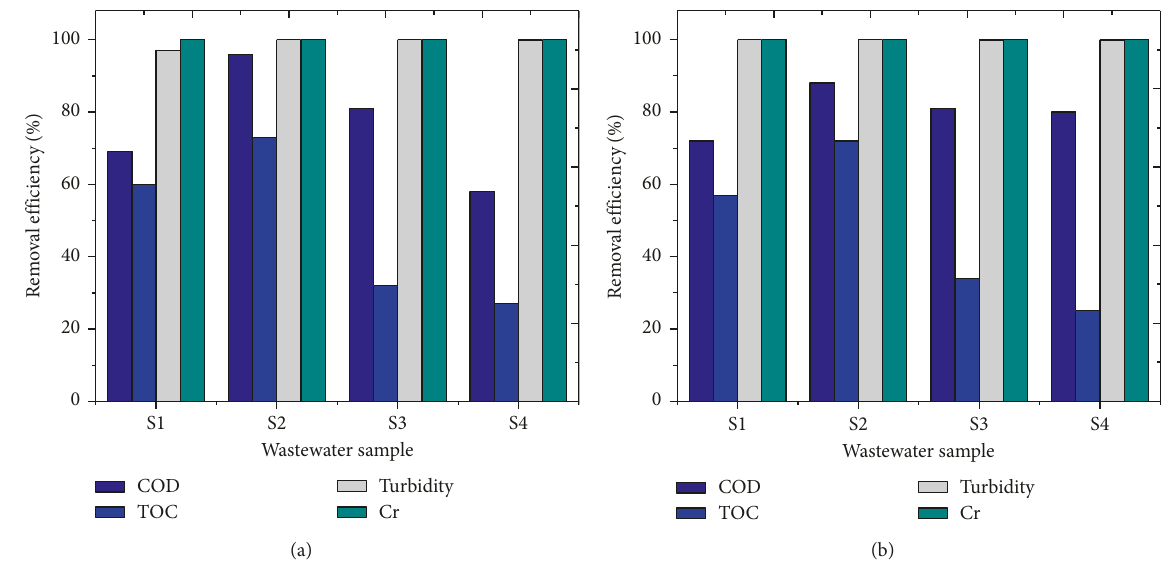
Figure 6: Evolution of factors (COD, TOC, turbidity, and chromium, %) as a function of wastewater sample at different stages of the tanning process for an EC system at 28mA/cm 2 during 60min and working with Fe (a) and Al (b) electrodes.